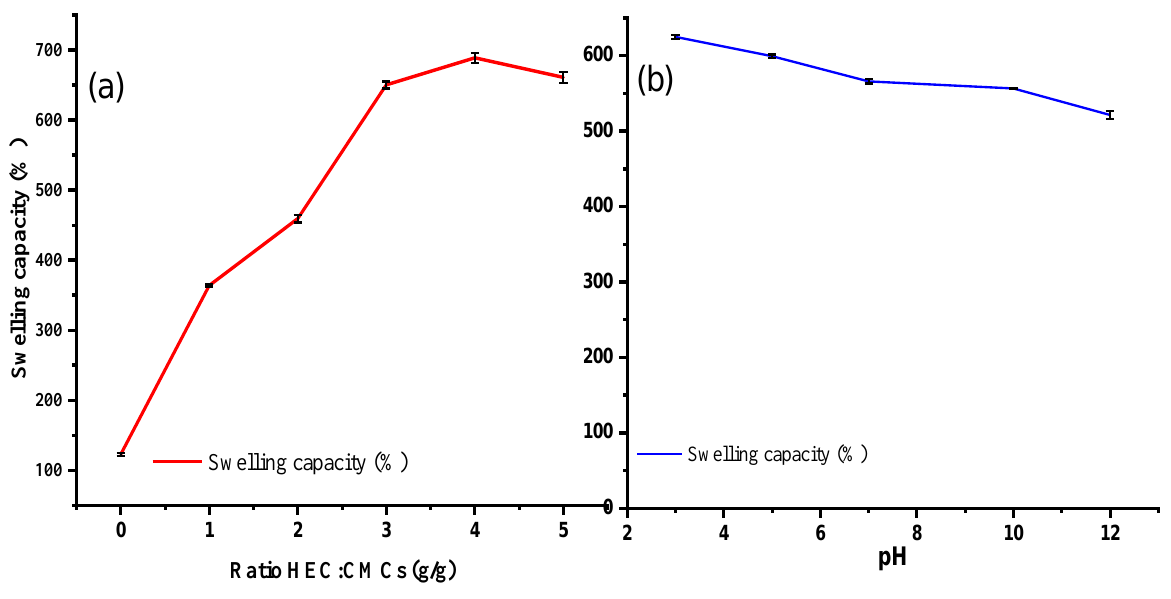
swelling capacity of 200% as compared to citric acid crosslinked CMC-HEC which had an Figure 1. Swelling capacity as a function of ( a ) HEC content and ( b ) pH of the swelling medium. equilibrium swelling capacity of 900% [52]. As can be observed from Figure 1, while CMCs had a higher swelling capacity as compared to Cs, chemical crosslinking of CMCs with HEC using citric acid resulted in a subsequent increase in the swelling capacity of the resultant hydrogels [36]. Higher swell- ing capacities were observed when the amount of HEC present in the hydrogels was in- creased from 0 to 5 g with the highest swelling capacity observed when the ratio of CMCs- HEC was 1:4 g/g, respectively. It is worth noting also that maximum water uptake was attained after 20 min in which 1 g of the hydrogel absorbed up to 7 g of water (≈700 %) to attain equilibrium (Figure 2). This fluid uptake is relatively higher as compared to carbox- ymethyl cellulose (CMC)-hydroxyethyl cellulose (HEC) hydrogels crosslinked with fu- maric acid which exhibited a 400 % swelling capacity [15,35]. The swelling capacity is de- pendent on the behaviour of individual components making up the hydrogels, the degree of crosslinking and the type of crosslinker used in the synthesis. For instance, CMC and HEC have been reported to have lower swelling capacities when individually crosslinked